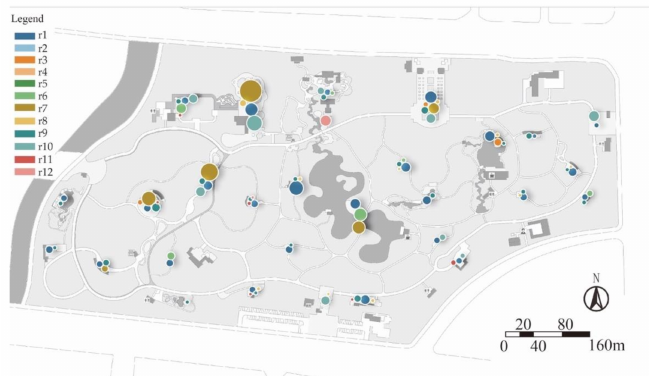
Figure A11. Spatial distribution of various recreational activity users in Zhujiang Park.